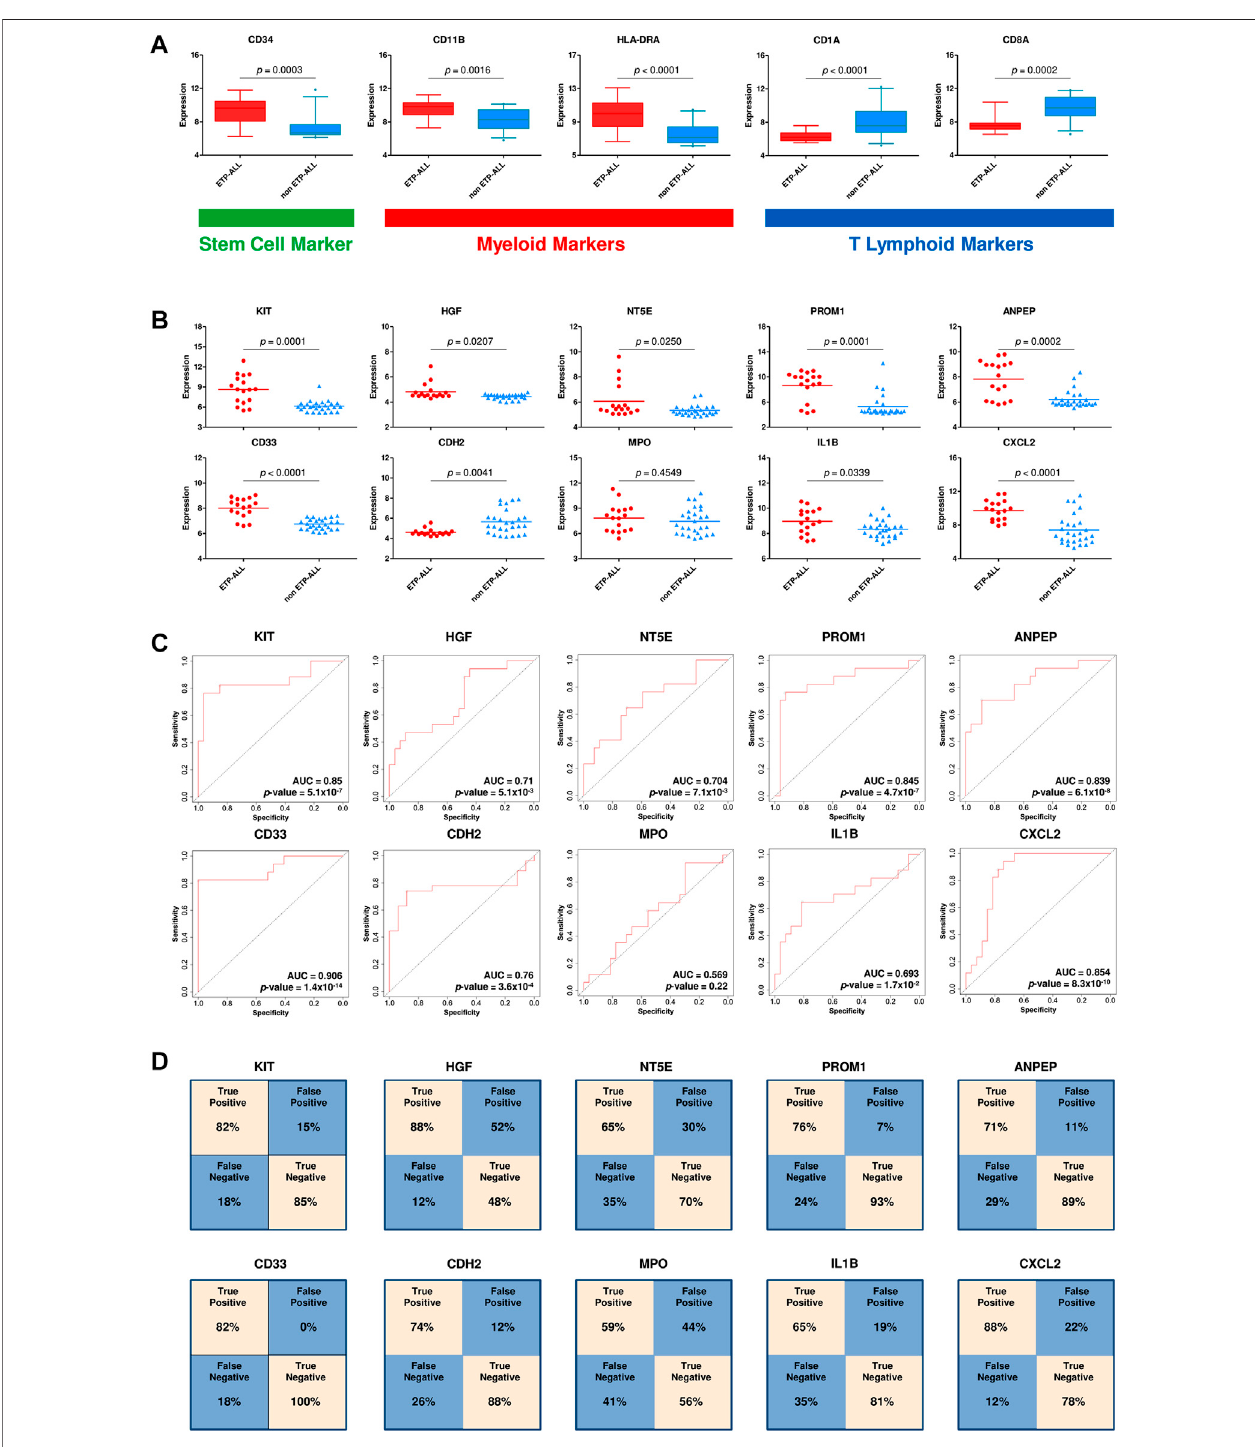
FIGURE 4 | Validation of the hub genes as diagnostic biomarkers of ETP-ALL. (A) Expression levels of conventional ETP-ALL markers in ETP-ALL and non-ETP- ALL groups from GSE78132 dataset. Statistical signi fi cance was calculated using two-tailed unpaired Student ’ s t-test. (B) Expression levels of hub genes in ETP-ALL and non-ETP-ALL groups from GSE78132 dataset. Two-tailed unpaired Student ’ s t-test was used to estimate the statistical signi fi cance. (C) Receiver operating characteristic(ROC)curvesofhubgenes.AUC(areaundercurve)valuesindicatepredictionaccuracyofthegenesasbiomarkers. (D) Confusionmatricesdenoting classi fi cation qualities of hub genes. For all hub genes apart from CDH2, ‘ True positive ’ indicates % of ETP-ALL cases with higher expression than ROC cutoff; ‘ False negative ’ indicates % of ETP-ALL cases with lower expression than ROC cutoff; ‘ False positive ’ indicates % of non-ETP-ALL cases with higher expression than ROC cutoff; ‘ True negative ’ indicates % of non-ETP-ALL cases with lower expression than ROC cutoff. The annotations are opposite for CDH2.